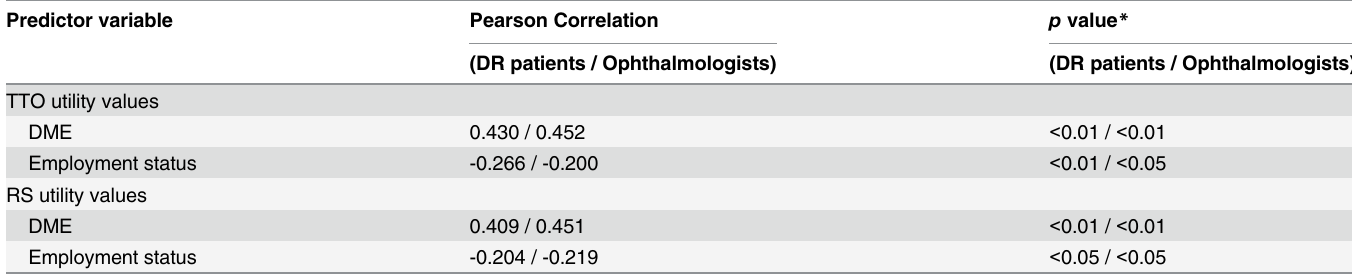
Table 6. Predictors of time trade-off and rating scale utility values from diabetic retinopathy patients and ophthalmologists, determined by bivari- ate analyses. Predictor